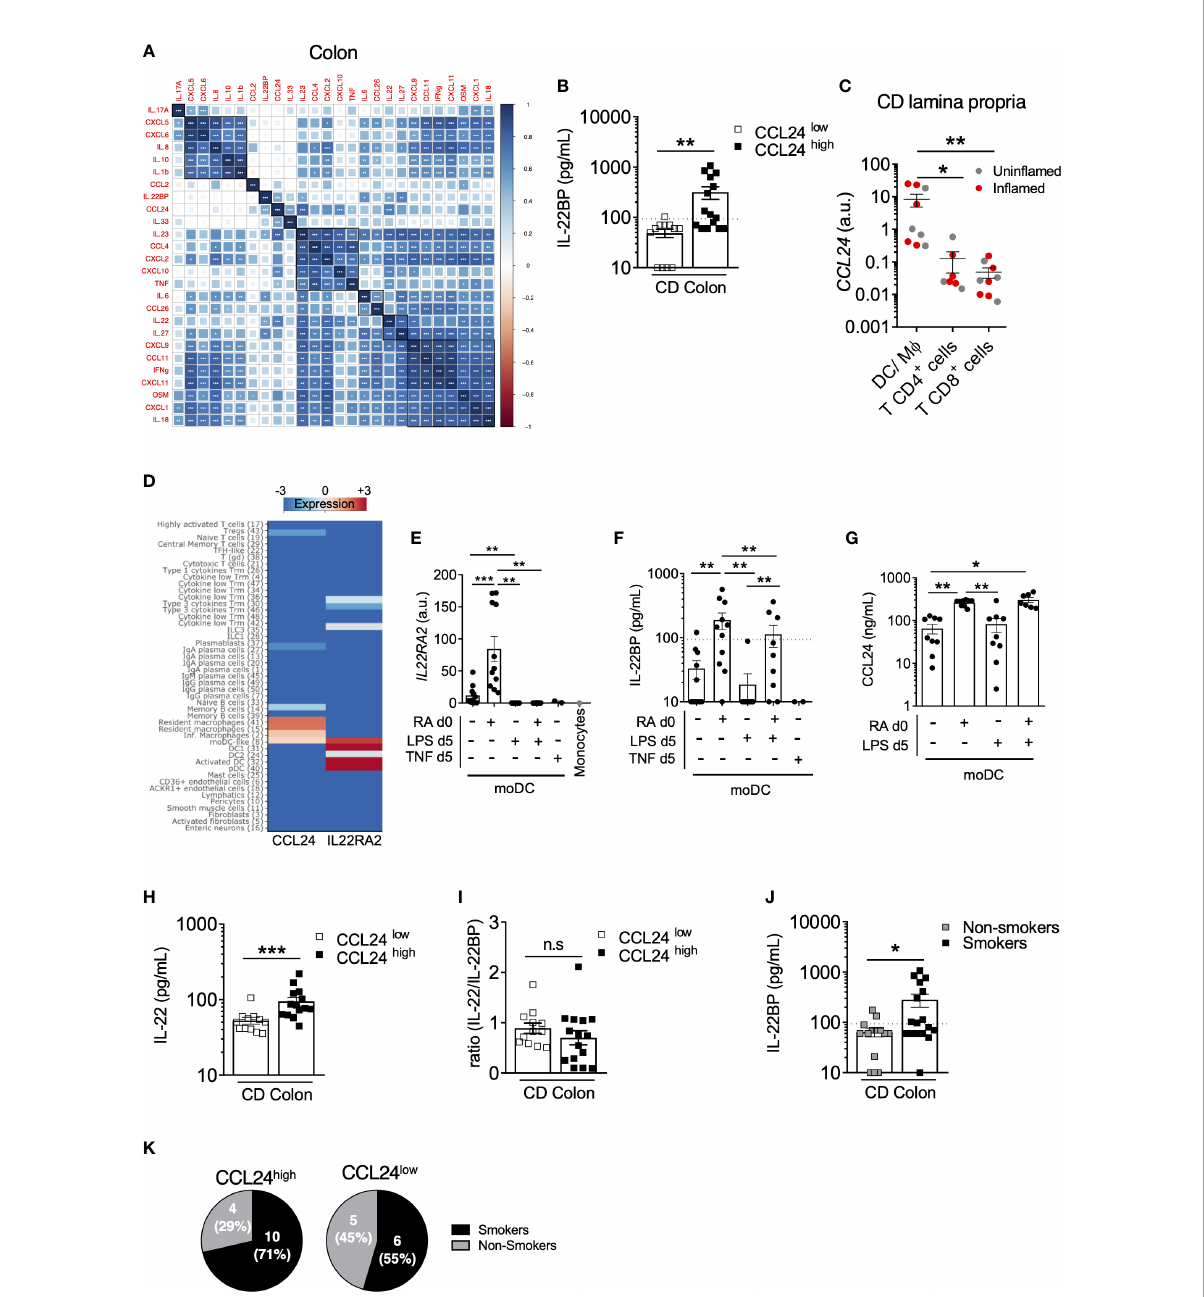
FIGURE 3 IL22BP levels correlate with CCL24 produced by monocyte-derived dendric cells in the CD colon. (A) Spearman correlation and hierarchical clustering of indicated cytokines quanti fi ed in culture supernatants of endoscopic colonic biopsies from 28 CD patients. (B) Comparison of soluble IL-22BP levels in CD patients strati fi ed into CCL24 low and CCL24 high patients based on the median level. (C) CCL24 expression was analyzed by RT-qPCR on FACS-sorted cells from CD lamina propria, as in Figure 2A. (D) Heatmap representing the expression of IL22RA2 and CCL24 in indicated cell types using the clustering analysis of a previously published single-cell RNA-sequencing (scRNA-seq) dataset (Martin JC, Cell, 2019). (E – G) Human blood classical monocytes from healthy donors were differentiated into monocyte-derived DC (moDC) with GM-CSF and IL-4 for 6 days in the presence of indicated ligands. At day 6 of culture IL22RA2 mRNA expression was analyzed by RT – qPCR in moDC (E) , and levels of IL-22BP (F) and CCL24 (G) were quanti fi ed in culture supernatants. (H, I) Comparison of soluble IL-22 (H) and IL-22/IL-22BP ratios (I) in culture supernatants of colonic CD biopsies from CCL24 high or CCL24 low patients. (J) Comparison of soluble IL-22BP levels in culture supernatants of colonic CD biopsies (n=32) from patients strati fi ed according to their smoking status. (K) Pie charts representing the proportion of active smokers vs. non-smokers in the colon of CCL24 high or CCL24 low CD patients. *P < 0.05, **P < 0.01, ***P < 0.001 ns, not signi fi